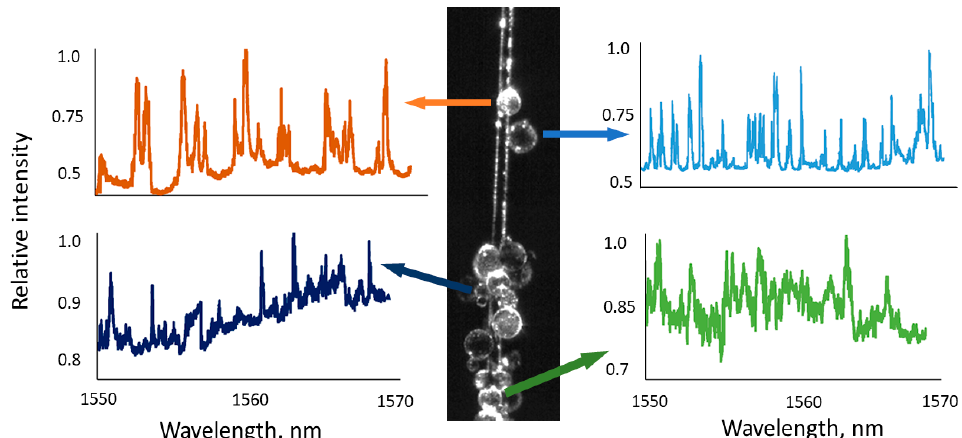
Figure 3. Intensity measurements of different PMMA microspheres while scanning laser from 1550 to 1570 nm. In the middle, a microscope image of tapered fiber and the excited PMMA microspheres can be seen. Arrows point to the intensity changes in each of the selected microspheres. Vertical axes show normalized relative intensity values.